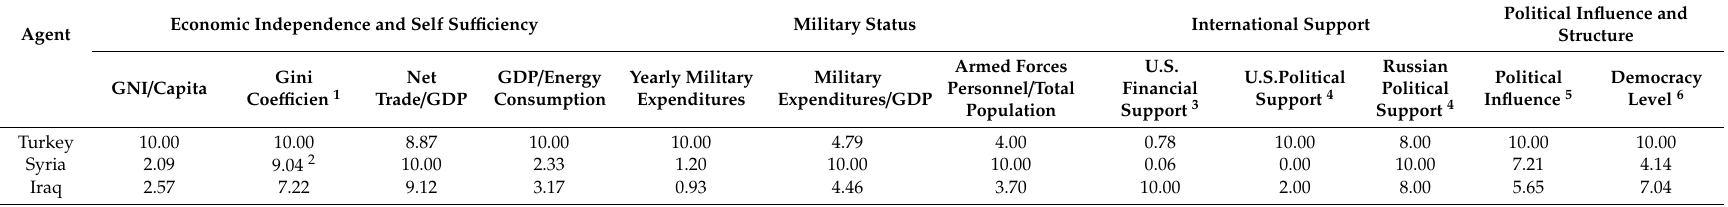
Table 2. Criteria and indicators applied to estimate the three countries’ negotiation power in the Euphrates River Basin (out of 10).